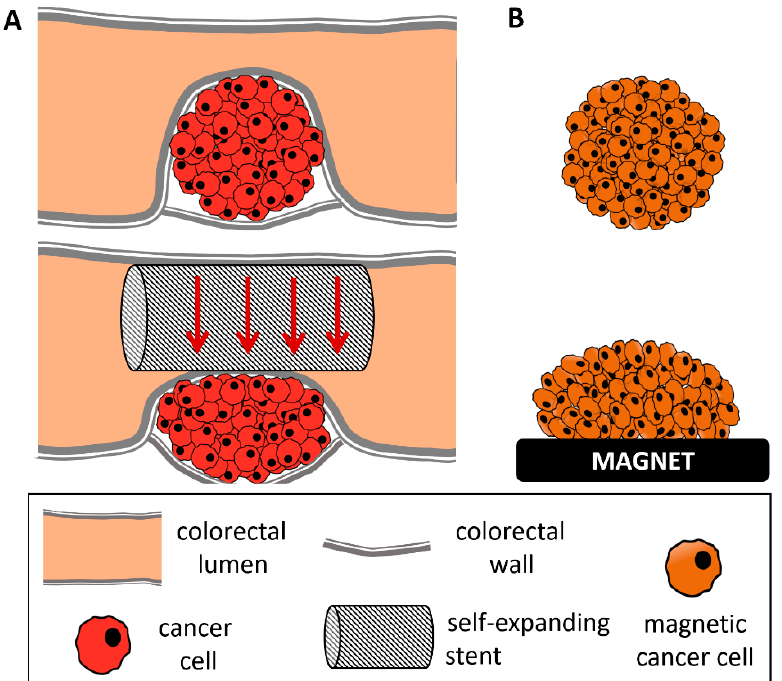
Figure 6. Schematic comparing an obstructive colorectal cancer treated with self-expanding stent and a magnetically compressed tumor spheroid. ( A ) Tumor growth within the colorectal wall, occluding the lumen of the colon almost entirely ( top ). To avoid this obstruction, a self-expanding stent is inserted inside the colorectal lumen and extended to obtain a re-opening of the lumen, up to 75% of its initial radius ( bottom ). This results in anisotropic compression of the tumor. ( B ) Representation of a magnetically molded tumor spheroid ( top ) and its anisotropic compression upon magnet application ( bottom ).